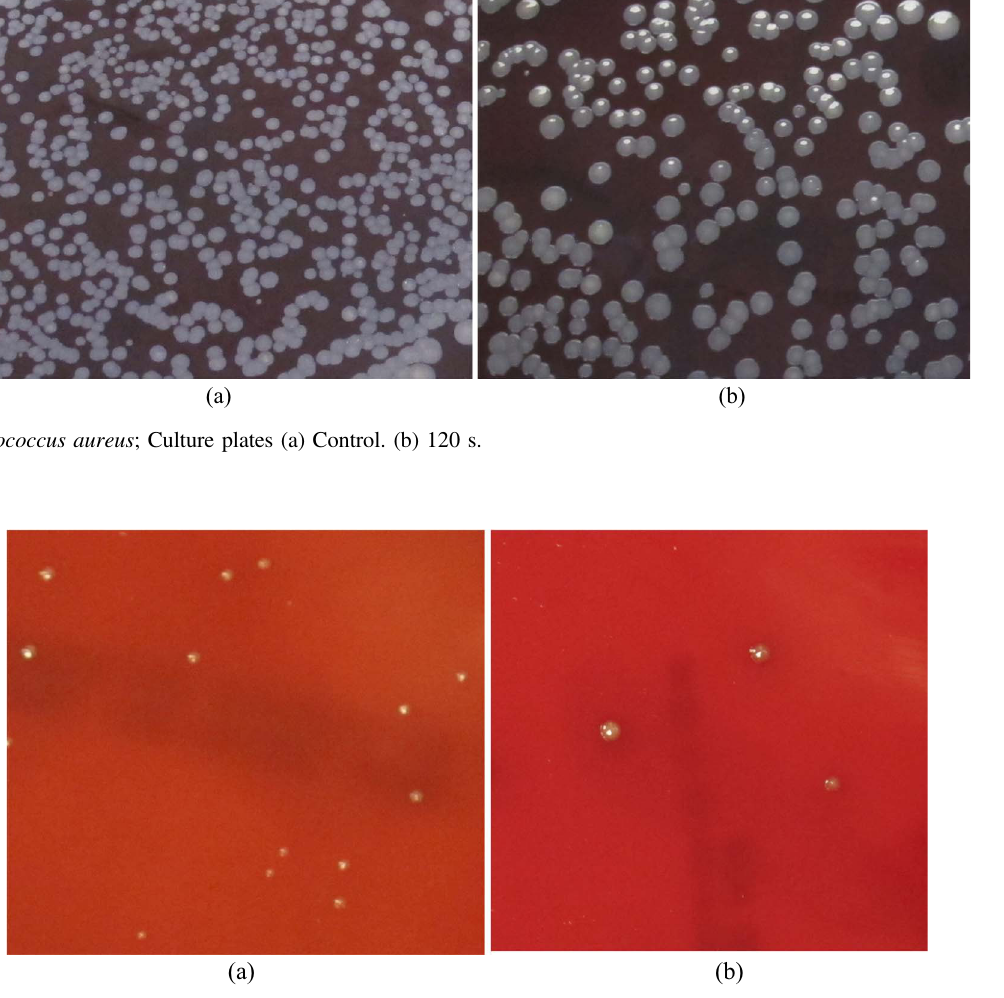
Figure 3. Porphyromonas gingivalis ; Culture plates (a) Control. (b) 120 s.